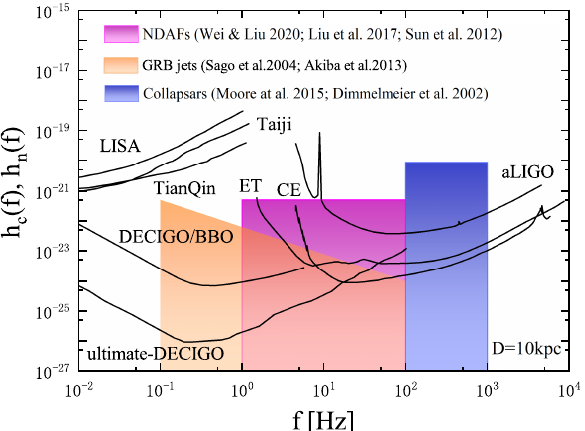
Figure 7. The characteristic amplitude of GWs from different sources in a collapsar. The blue, purple, and orange shaded boxes represent the collapsar phase [152,156], NDAFs [130,133,135] and GRB jet phase [157,158], respectively. The gray lines show the sensitivity lines (the noise amplitudes h n ) of aLIGO, ET, CE, LISA, Taiji, TianQin, DECIGO/BBO, and ultimate-DECIGO. The distance is 10 kpc. (adapted with permission from Ref.